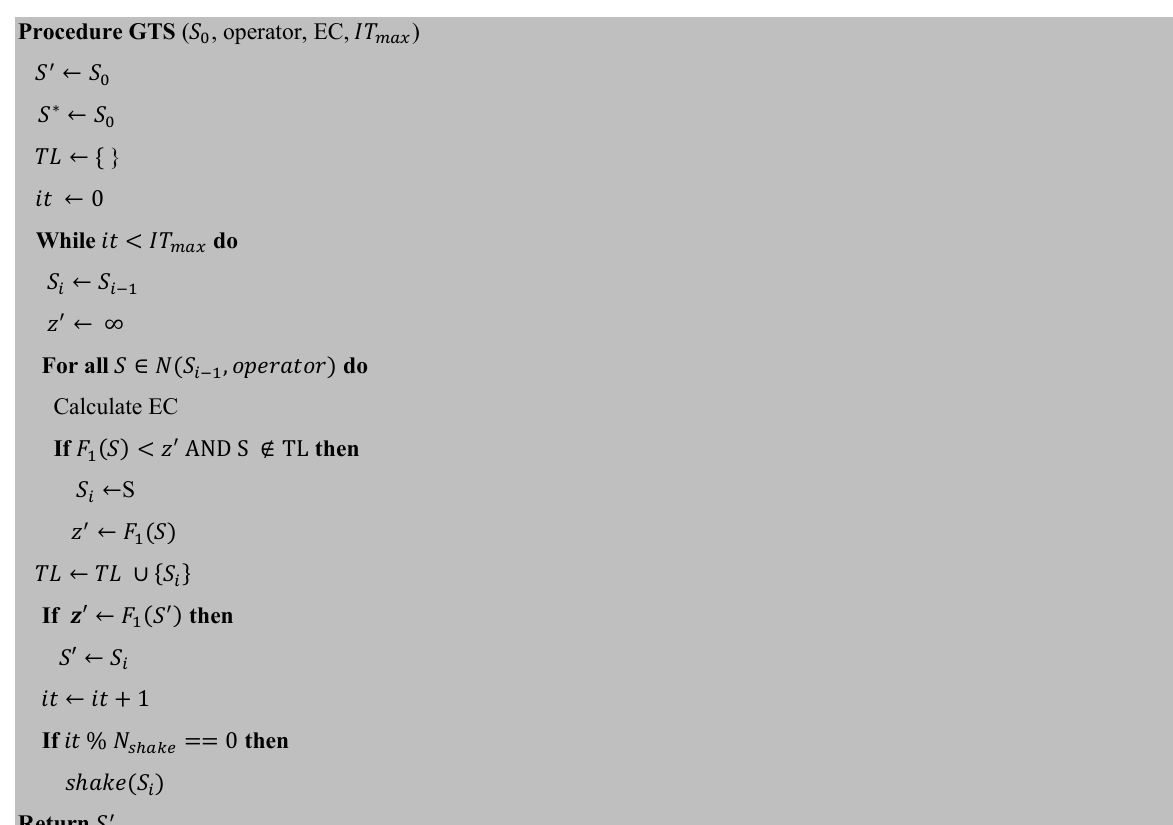
Algorithm 3. Granular Tabu Search